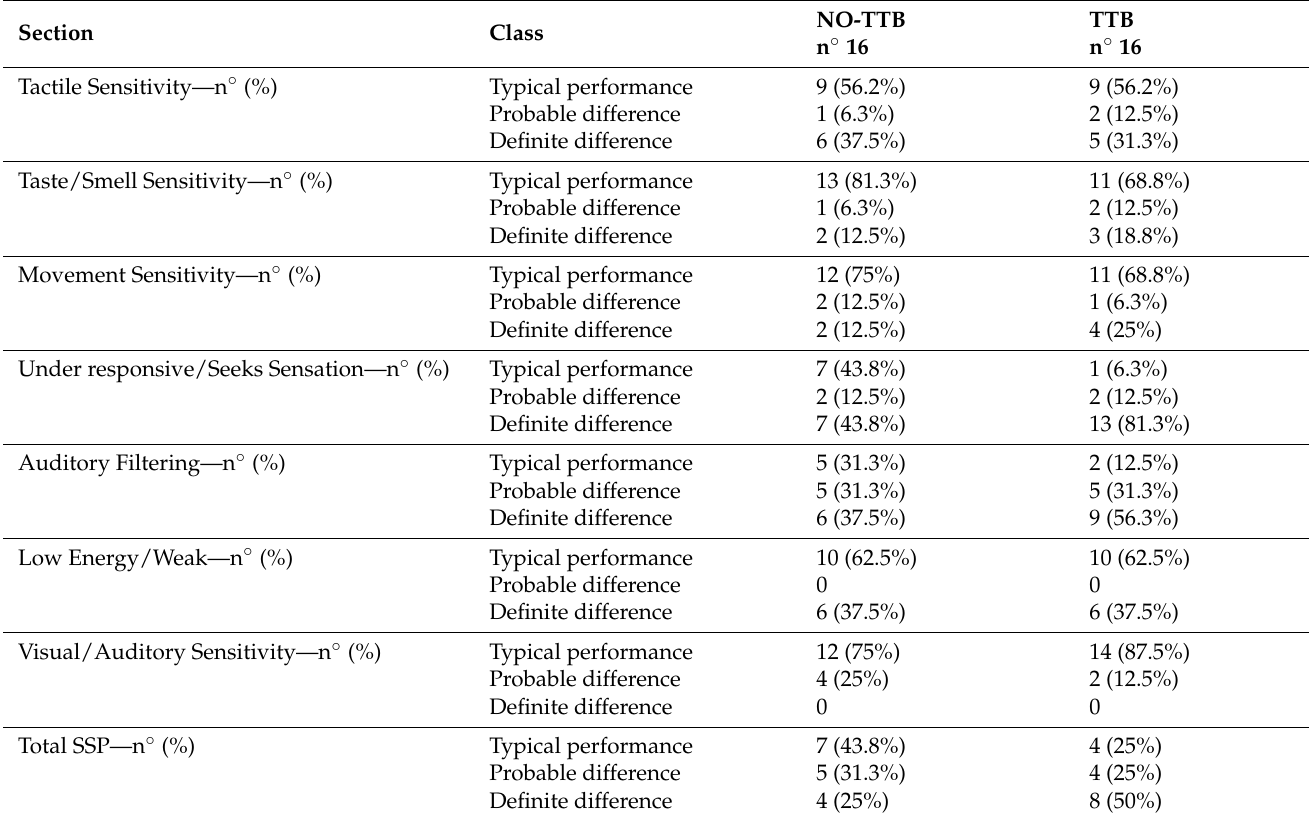
Table 2. Performance on the SSP for NO-TTB and TTB groups.